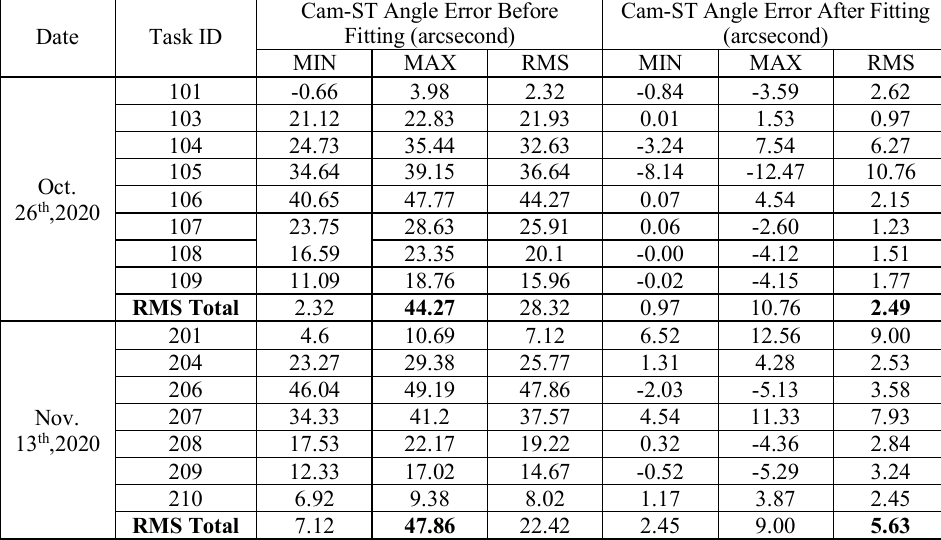
Table 3 . Cam-ST angle error before and after